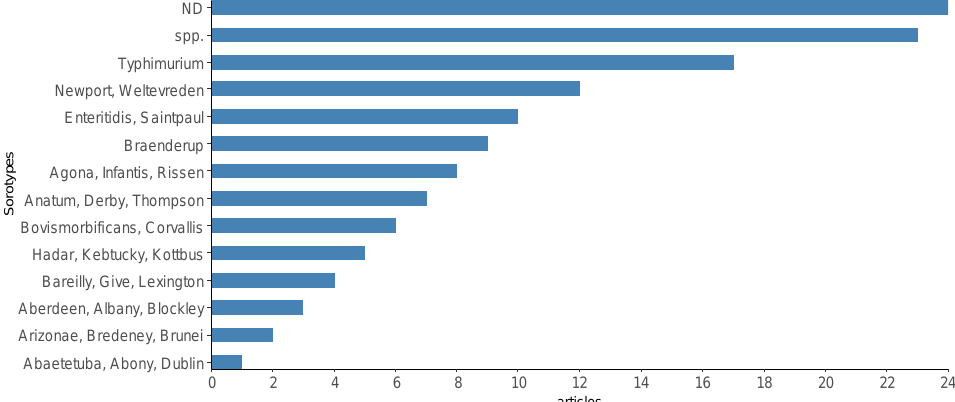
Figure 10. Some of the most reported Salmonella serotypes by the scientific articles selected in the integrative review on the microbiological diagnoses of Salmonella spp. in aquaculture between 2000 and 2020. Legend: “ND”— undetected Salmonella ; “spp.”— Salmonella spp. reported.